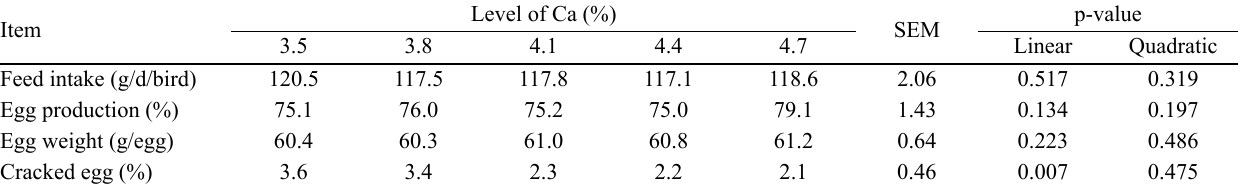
Table 3. Effect of graded levels of dietary calcium on production performance in the aged laying hens 1,2